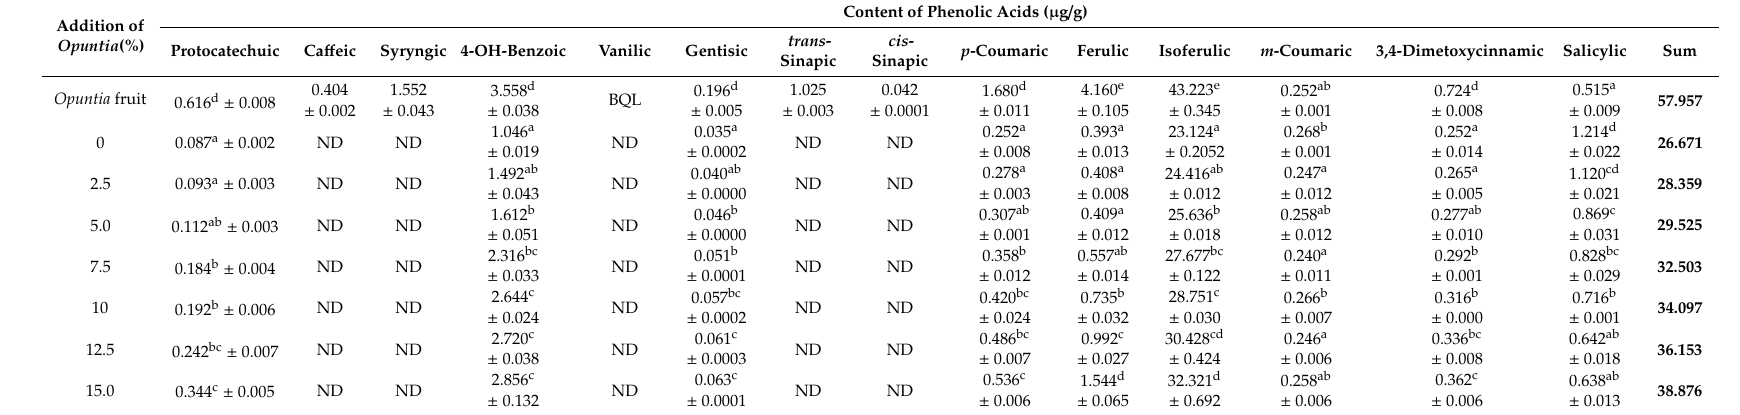
Table 2. Content of phenolic acids in Opuntia fruit and gluten-free pasta samples enriched with Opuntia fruit addition (n = 3; mean ± SD). Addition of Opuntia